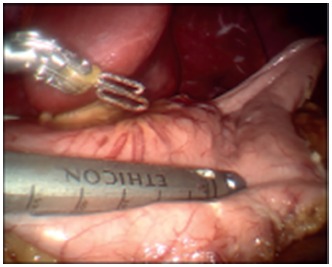
Creation of sleeve over a 34-French bougie-sized Edlich tube with a
linear stapler